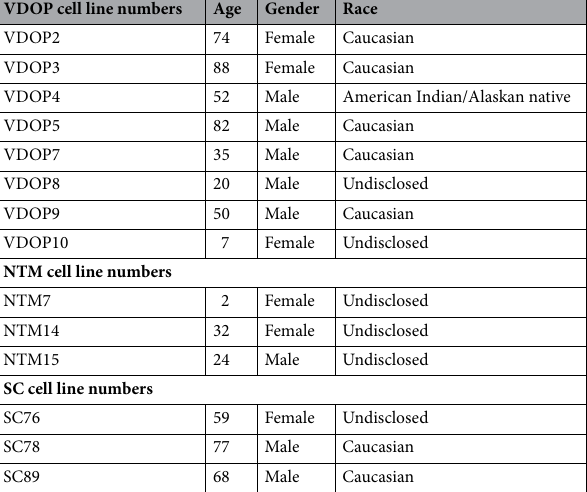
Table 1. Demographic information of human donors of VDOP, NTM and SC primary cell